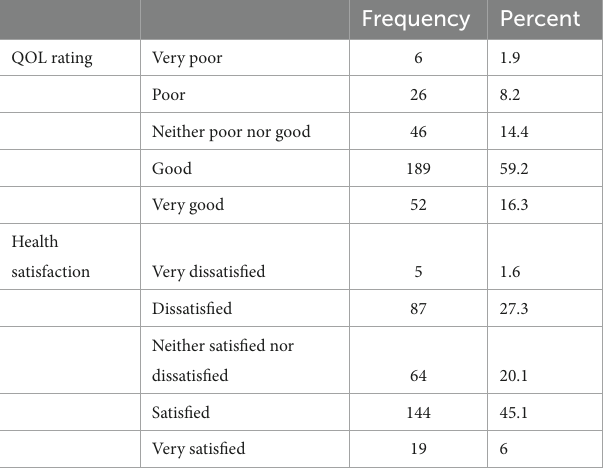
TABLE 3 Health and quality of life ratings with the sample ( N = 319).